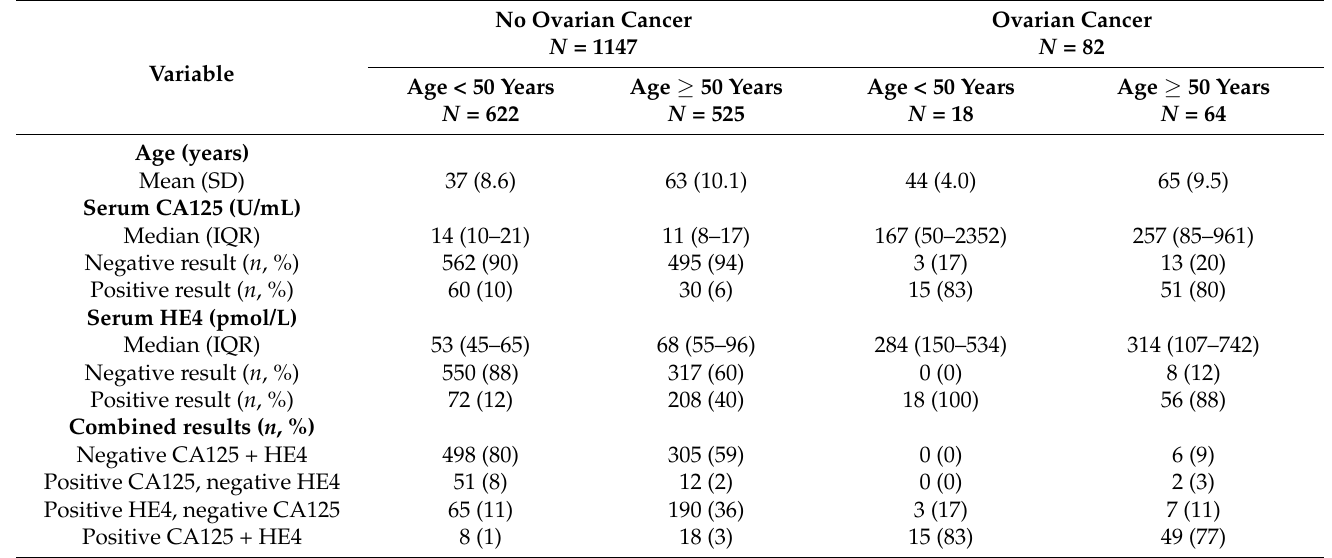
Table 1. Summary of biomarker and eGFR levels in women with and without ovarian cancer, stratified by age.